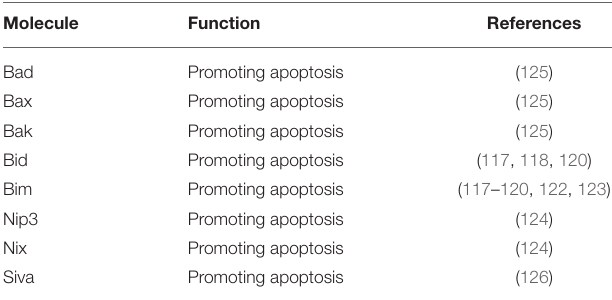
TABLE 2 | Potential proapoptotic molecule targets for enhancing CAR T cell persistence. Molecule